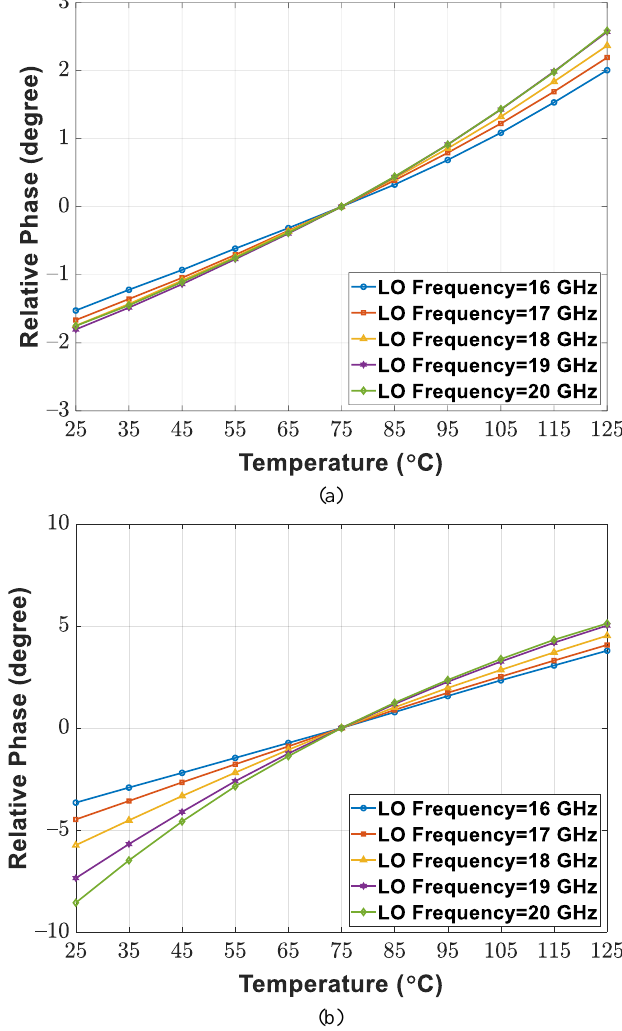
Figure 10. Simulated relationship between the relative phase of LO signal and environment tempera- ture under ( a ) activating and ( b ) deactivating bandgap reference voltage biasing.